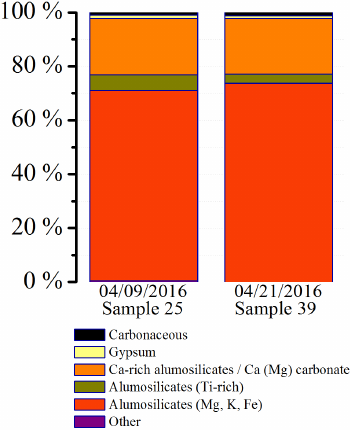
Figure 18. Chemical composition of single aerosol particles from electron microscopy of sample 25 (9 April) and sample 39 (21